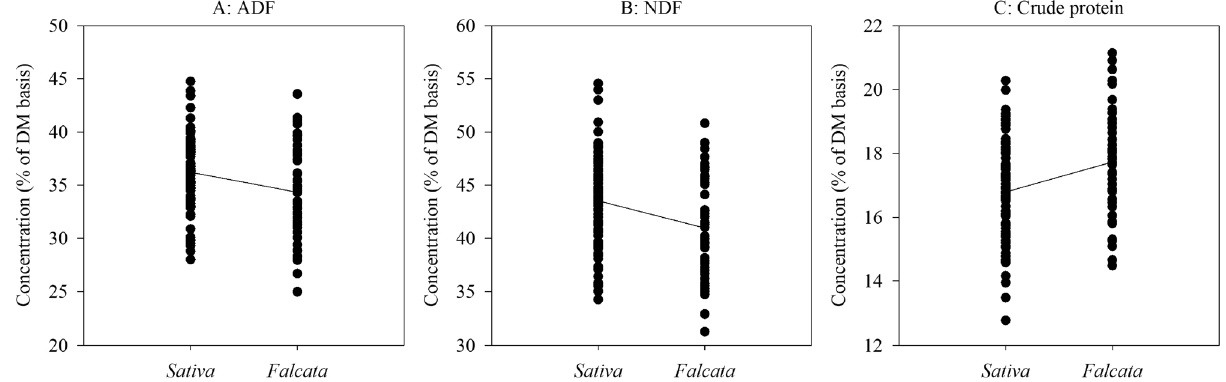
Figure 8. Trend of three nutritive value traits changes between sativa and falcata sub-clusters of 14 alfalfa populations with long-term grazing history.